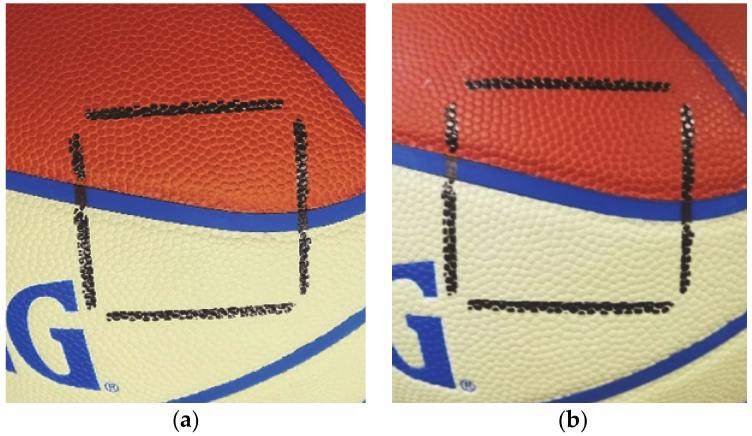
Figure 13. Results of degradation test on the surface of a regular basketball before ( a ) and after ( b ) 300 min of 275 nm radiation at an irradiance of 1.64 W/m 2 , amb. temperature is 25 ◦